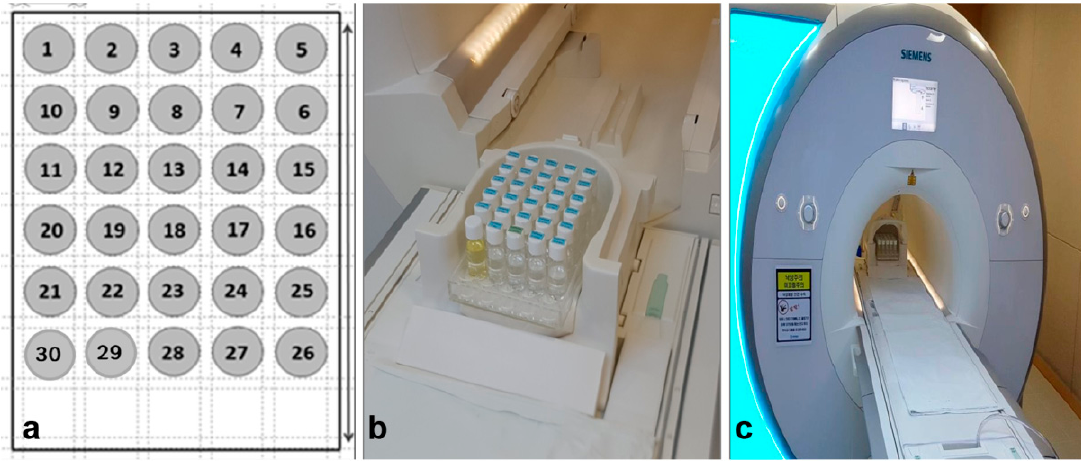
Figure 1. MR phantom and MRI apparatus. ( a ) Schematic diagram of the MRI phantom; ( b , c ) photographs of the MR phantom and apparatus. MR, magnetic resonance; MRI, magnetic resonance imaging.